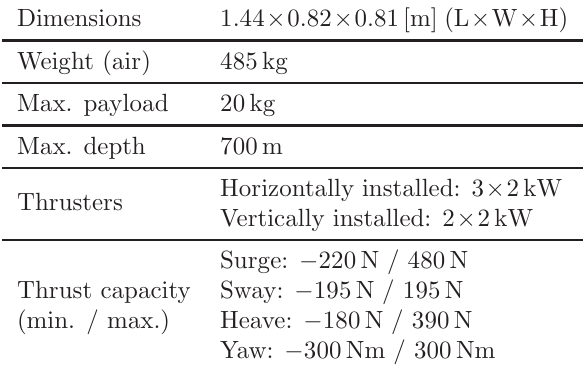
Table 5: Basic specifications of Minerva